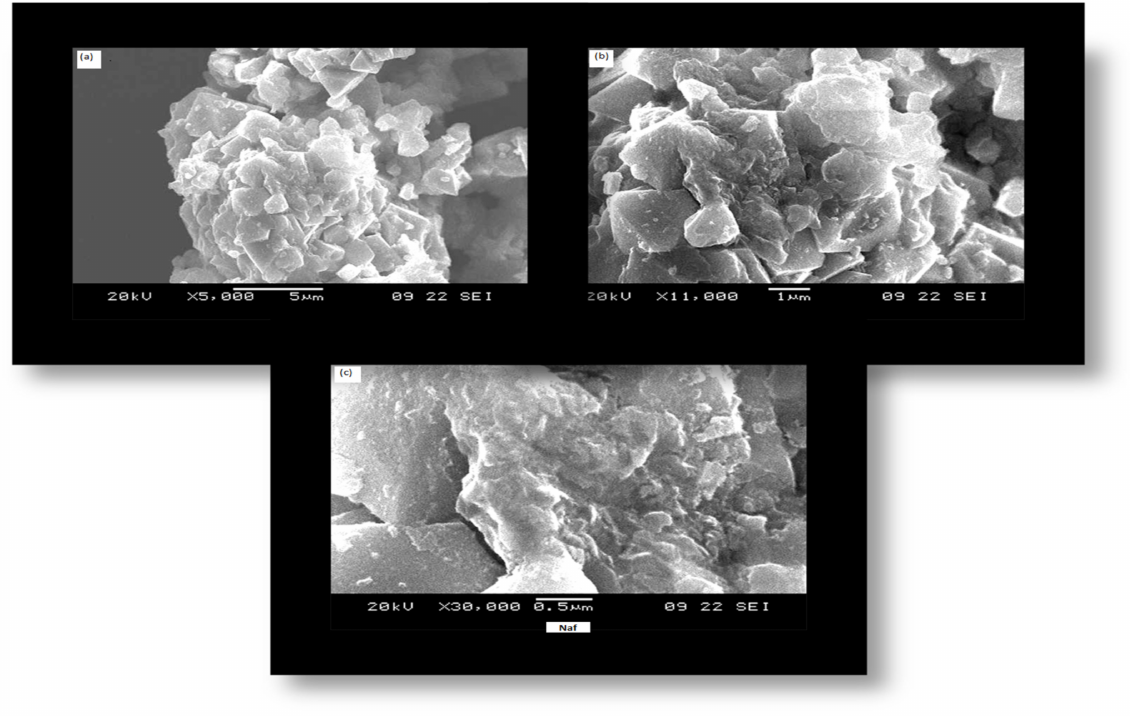
Figure 4. SEM images of cobalt oxide nanoparticles synthesized from Fusarium oxysporum